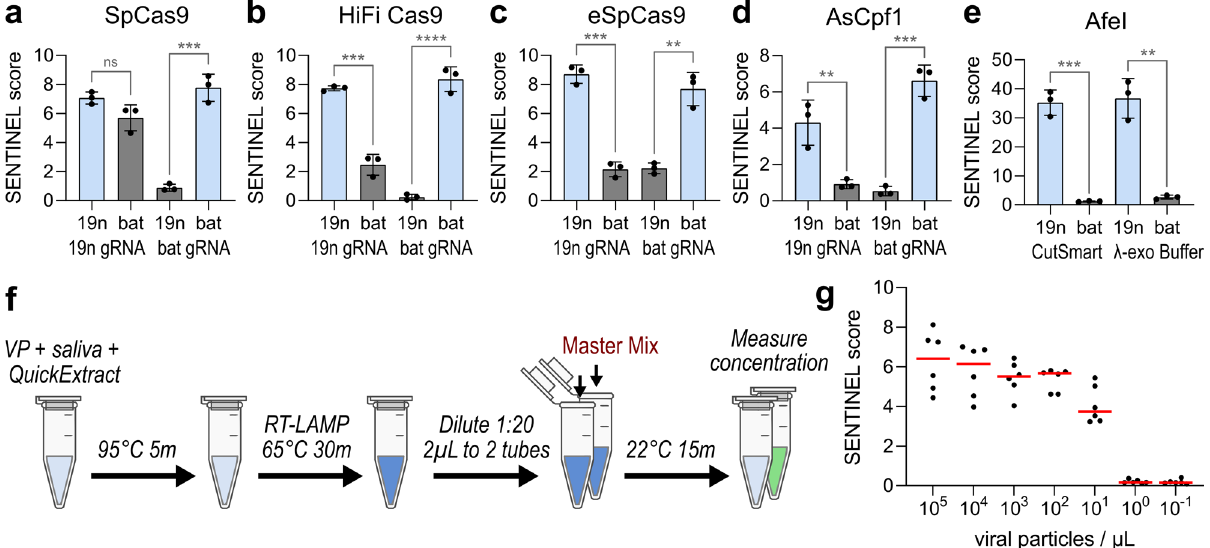
Fig. 4 Compatibility with different sequence-speci fi c endonucleases and with viral particles in human saliva. a – d Use of SENTINEL to detect the N-gene of SARS-CoV-2 (19n) vs. bat-SL-CoVZC45 (bat), using guide RNA targeting the N-gene of SARS-CoV-2 (19n gRNA) vs. bat-SL-CoVZC45 (bat gRNA). a Wild type SpCas9, b HiFi Cas9, c eSpCas9, and d AsCpf1 were used as the endonuclease. Light blue bars indicate expected positive samples, while gray bars indicate expected negative samples. e Use of AfeI as the endonuclease to discriminate between a single-nucleotide difference in sequence between the N-gene of SARS-CoV-2 (19n) and bat-SL-CoVZC45 (bat). CutSmart, and the λ -exo buffer used with other endonucleases, were both compatible. a – e All error bars represent ±1 standard deviation from mean, from three experimental replicates plotted as round data points. n.s. indicates not signi fi cant, * indicates p < 0.05, ** indicates p < 0.01, and *** indicates p < 0.001 from Student ’ s t -test. f Schematic of SARS-CoV-2 viral particle detection from human saliva using SENTINEL. g Limit of detection from serial dilutions of viral particles in viral transport media, which was mixed into saliva before subject to the SENTINEL assay. Red lines correspond to median of six experimental